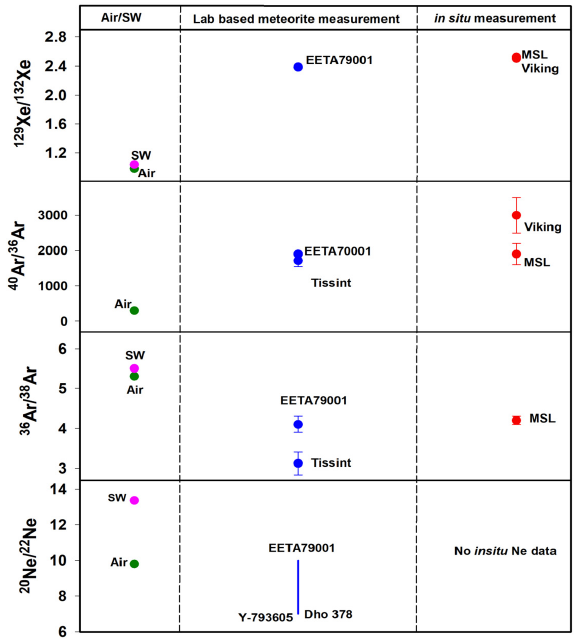
Figure 3. Neon, argon, and xenon isotopic composition in the solar wind (SW), Earth atmosphere, Martian meteorite measurements, and in situ measurement on Mars. In the figure, we report 20 Ne / 22 Ne values in SW [60] and in Martian meteorites [35–62]. In Martian meteorites, the 20 Ne / 22 Ne ratios are in the range 7.0 to 10.6 [38]. The isotopic ratio in meteorites are 36 Ar/ 38 Ar = 3.5–4.6 [62], 40 Ar/ 36 Ar = 1714 ± 170 [46] and 2050 ± 70 [63] 129 Xe/ 132 Xe = 2.384 ± 0.020 [64]. For the in situ measurements 36 Ar/ 38 Ar = 4.2 ± 0.1 [31], 40 Ar/ 36 Ar = 1900 ± 300 (MSL) [40]; 3000 ± 500 (Viking) [65], 129 Xe/ 132 Xe = 2.522 [41]. Table 4. The noble gas isotopic ratios as measured by the Viking [20] and Curiosity missions [31–41]. Isotopic Ratios Viking Curiosity